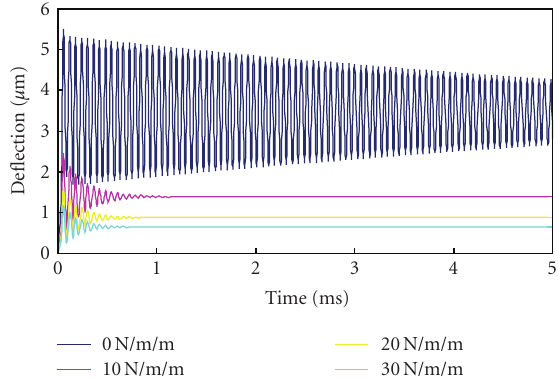
Figure 4: Deflections near the middle of an electrostatic fixed-fixed actuator for various residual stresses.